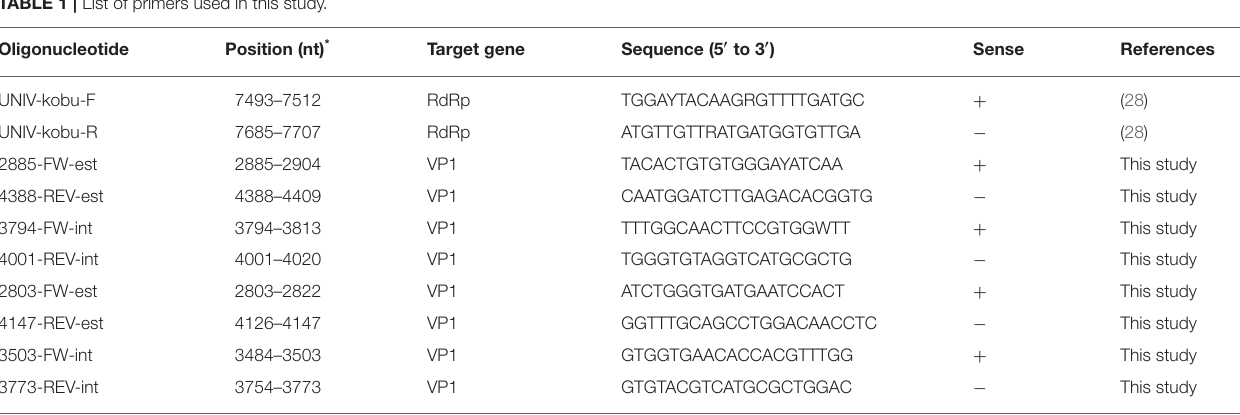
TABLE 1 | List of primers used in this